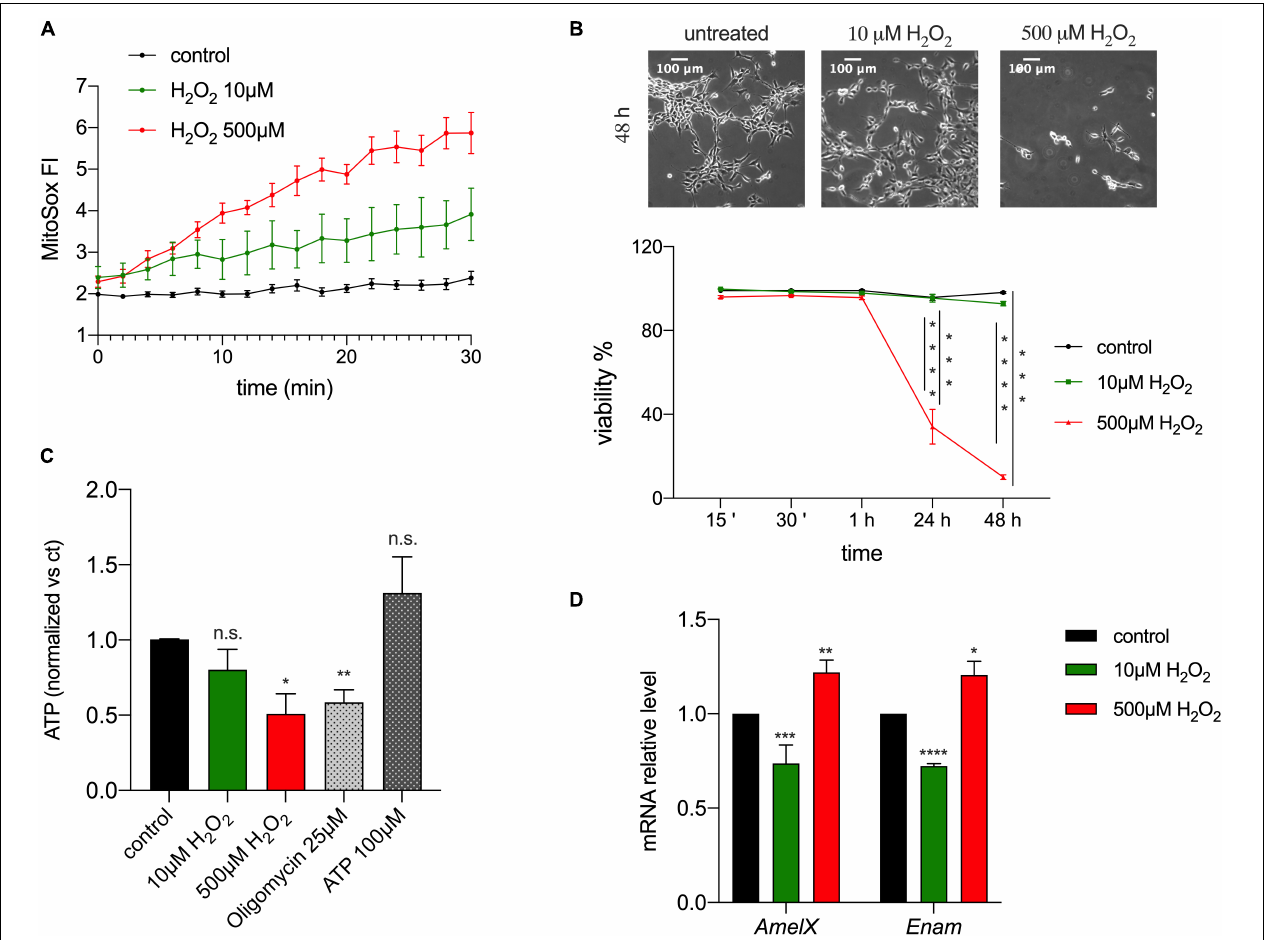
FIGURE 4 | ROS modulates enamel gene expression. (A) H 2 O 2 treatment of LS8 cells elicited a dose dependent enhancement of the MitoSOX fluorescence. (B) LS8 cells viability was significantly decreased upon treatment with H 2 O 2 500 µ M, but not 10 µ M (scale bar = 100 µ m). (C) ATP content decreased when LS8 cells were exposed to 500 µ M of H 2 O 2 after 15 min. (D) LS8 cells exposed to both H 2 O 2 concentrations (10 and 500 µ M) show altered expression of AmelX and Enam mRNA levels. Data represent mean ± SEM from a minimum of three independent experiments (* P < 0.05, ** P < 0.005, *** P < 0.0001, two tailed unpaired Student’s t